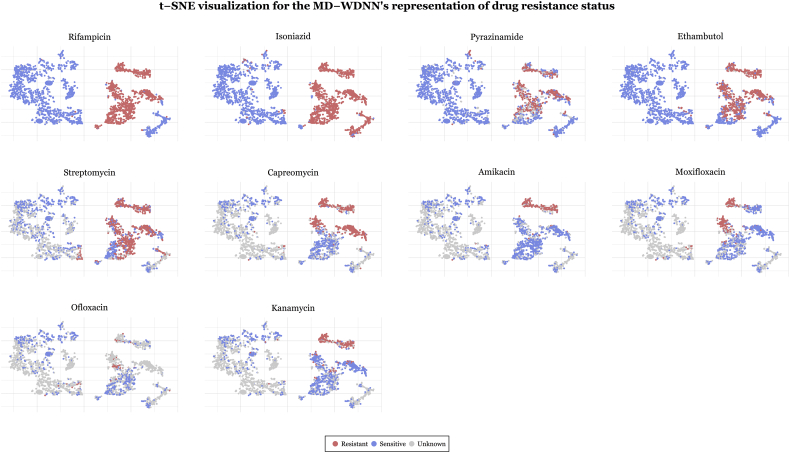
t-SNE visualization for the final output layer of the MD-WDNN. The final layer predictions, originally in 11 dimensions, were projected onto two dimensions. Each point is an MTB isolate, colored according to its resistance status with respect to the corresponding drug.